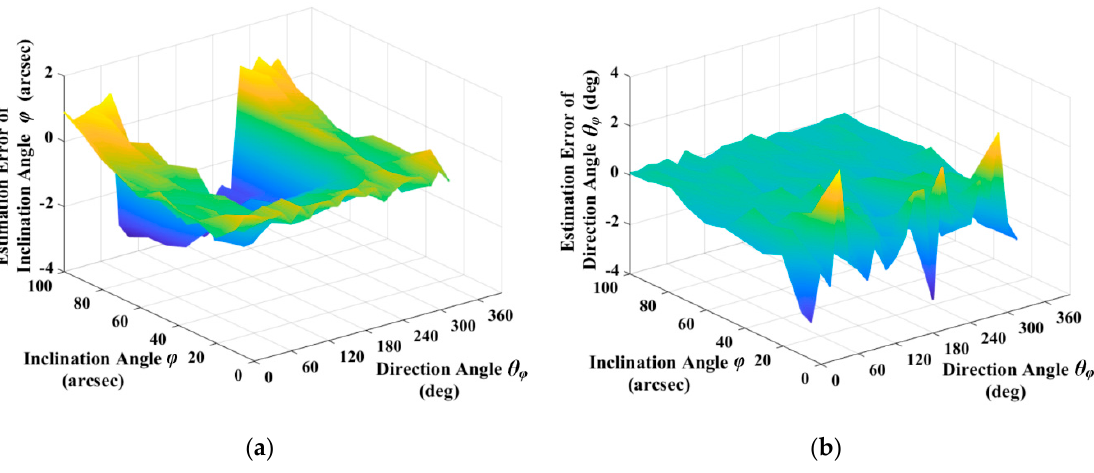
Figure 12. Estimation error of Inclination Angle ϕ and Direction Angle θ ϕ : ( a ) Estimation error of inclination angle with different inclination angle and direction angle; and, ( b ) Estimation error of direction angle with different inclination angle and direction angle.